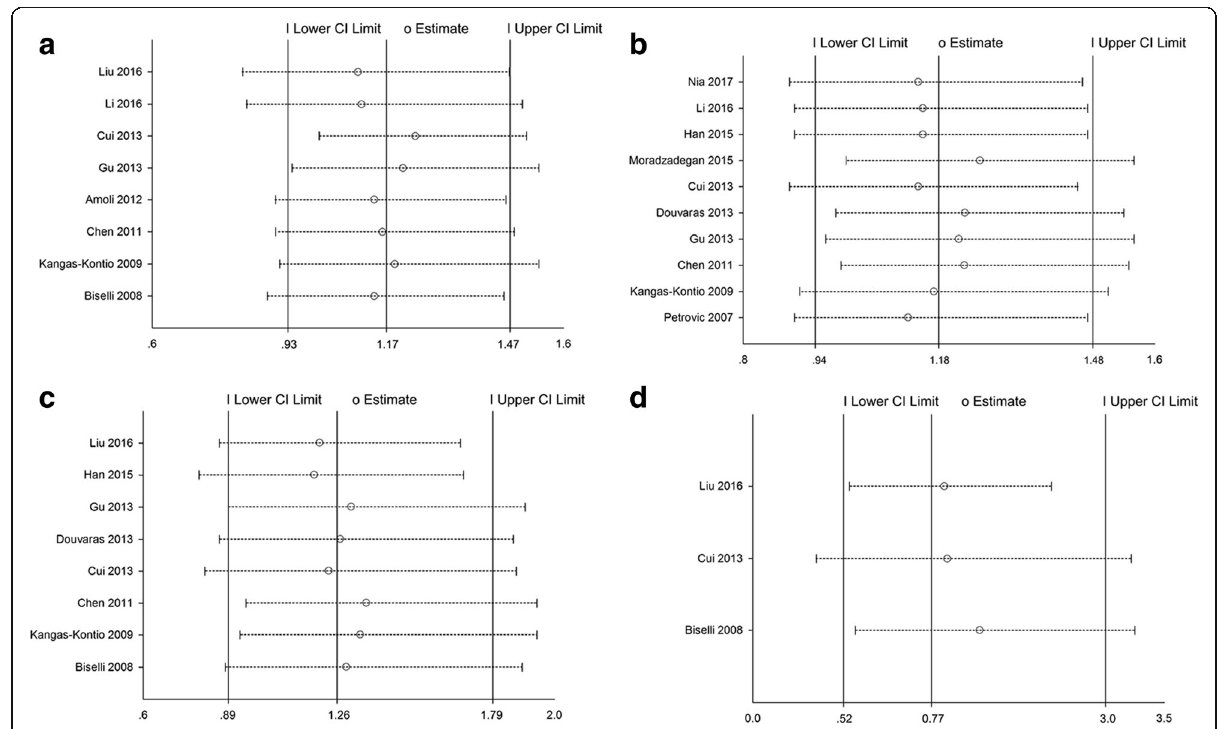
Fig. 2 Sensitivity analysis on the association between VEGF gene polymorphisms and susceptibility to CAD. a Sensitivity analysis for rs699947 and CAD risk; b Sensitivity analysis for rs2010963 and CAD risk; c Sensitivity analysis for rs3025039 and CAD risk; ( d ) Sensitivity analysis for rs1570360 and CAD risk. Abbreviation: CI = confidence